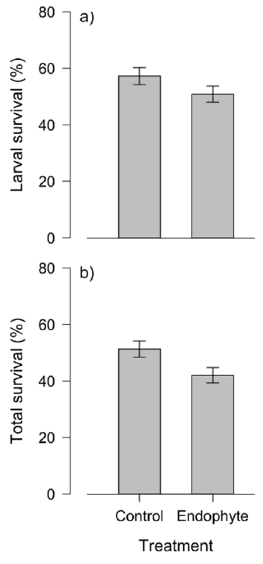
Figure 1. Mean ( ± SE) survival of second-instar eastern spruce budworm ( a ) to pupation (i.e., larval survival) and ( b ) to adult emergence (total survival) on white spruce trees with (Endophyte) or without (Control) a native endophytic fungus. n = 14 control and 14 endophyte trees.